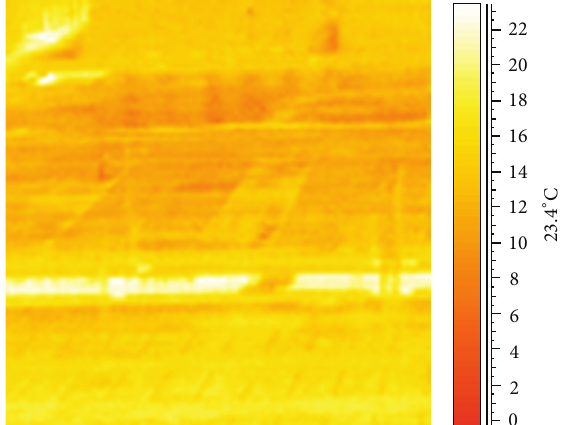
Figure 7: The constructed TITI at 10.30 a.m.